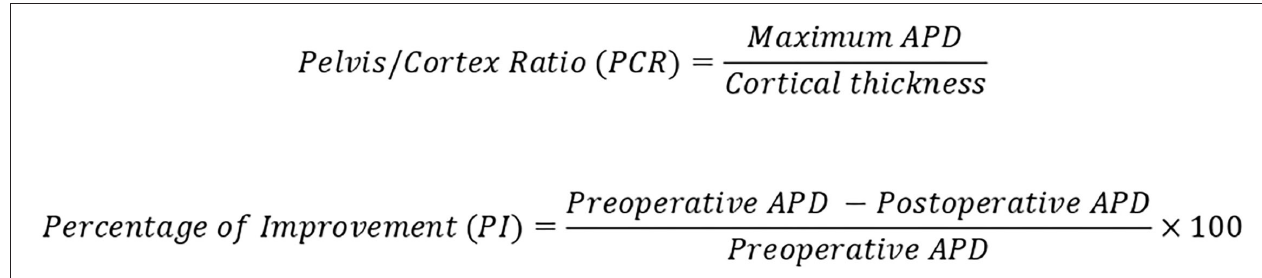
FIGURE 1 | Pelvis/cortex ratio and percentage of improvement (PI) in the renal pelvis APD.